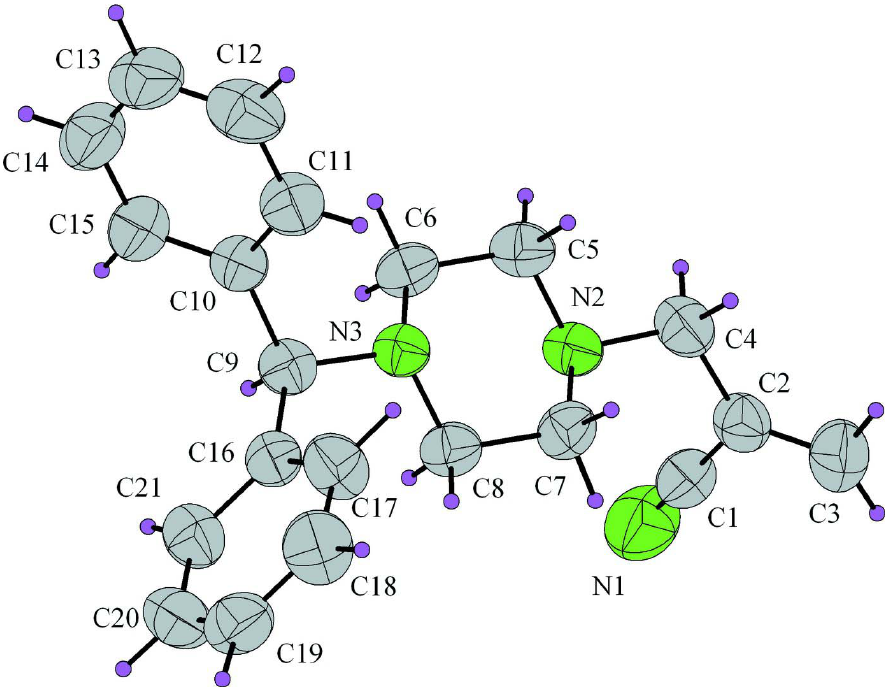
Figure 1 Représentation de la molécule C 2-[(4-benzhydrylpiperazin-1-yl)methyl]acrylonitrile Crystal